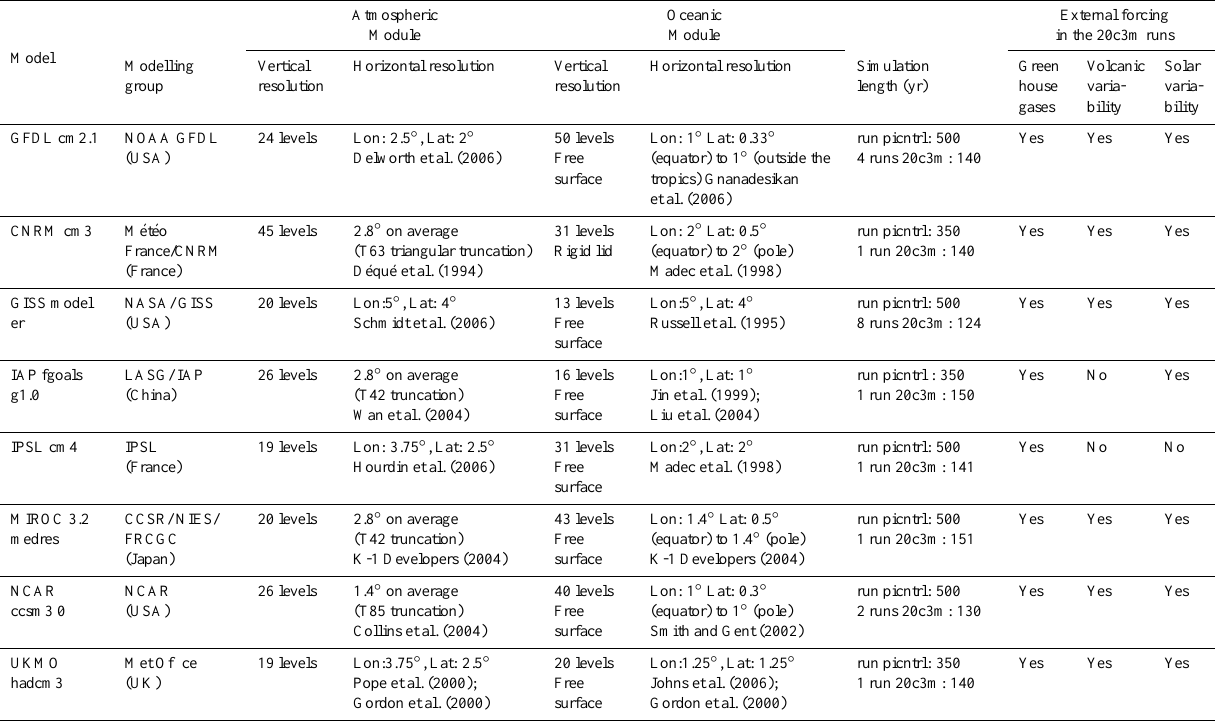
Table 1. List of coupled Atmosphere-Ocean General Circulation Models considered in this study with key characteristics. Model